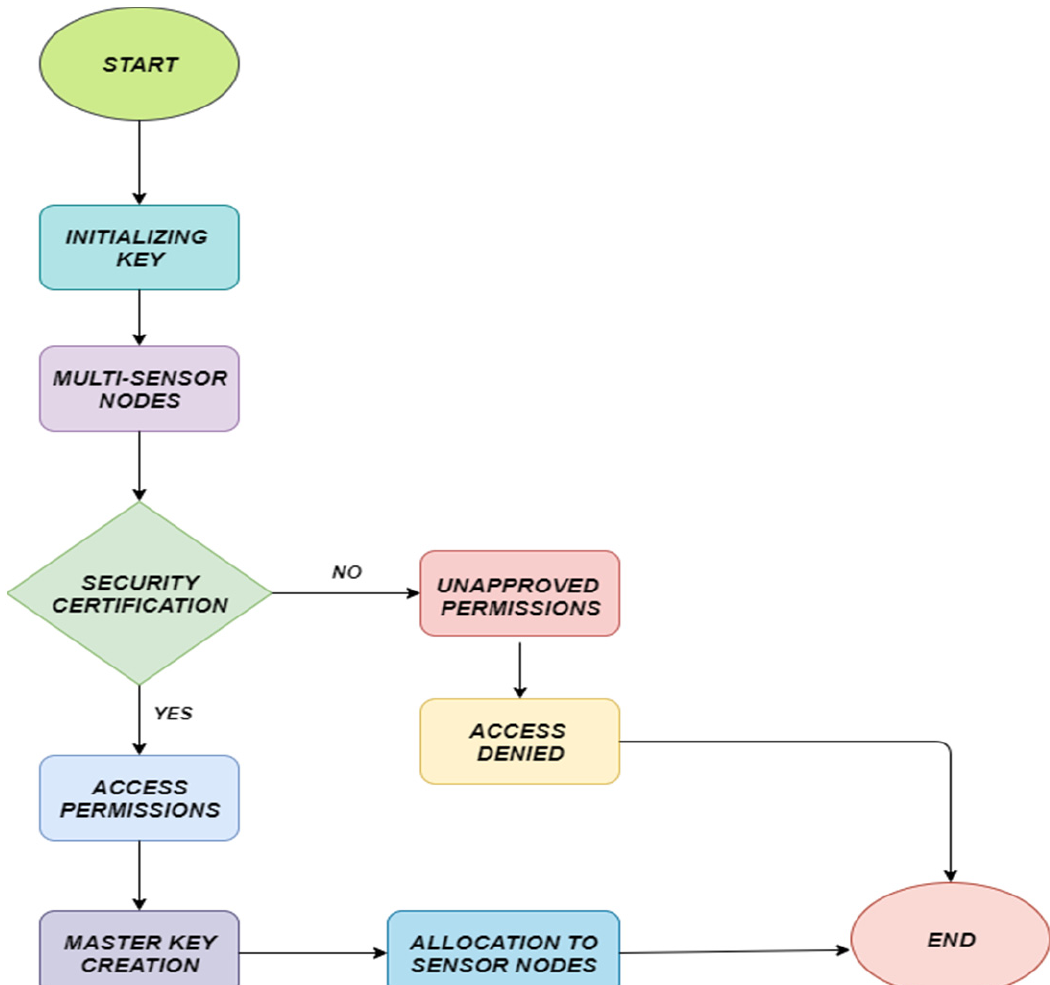
Figure 4. Proposed security algorithm for 5G-enabled IoT system.